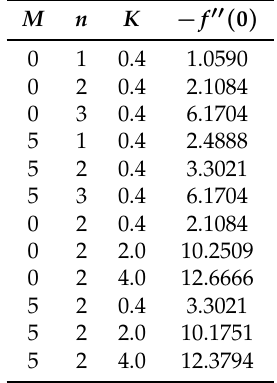
Table 3. Variation of the numerical results for skin friction − f (cid:48)(cid:48) ( 0 ) with different values of M , n , and K